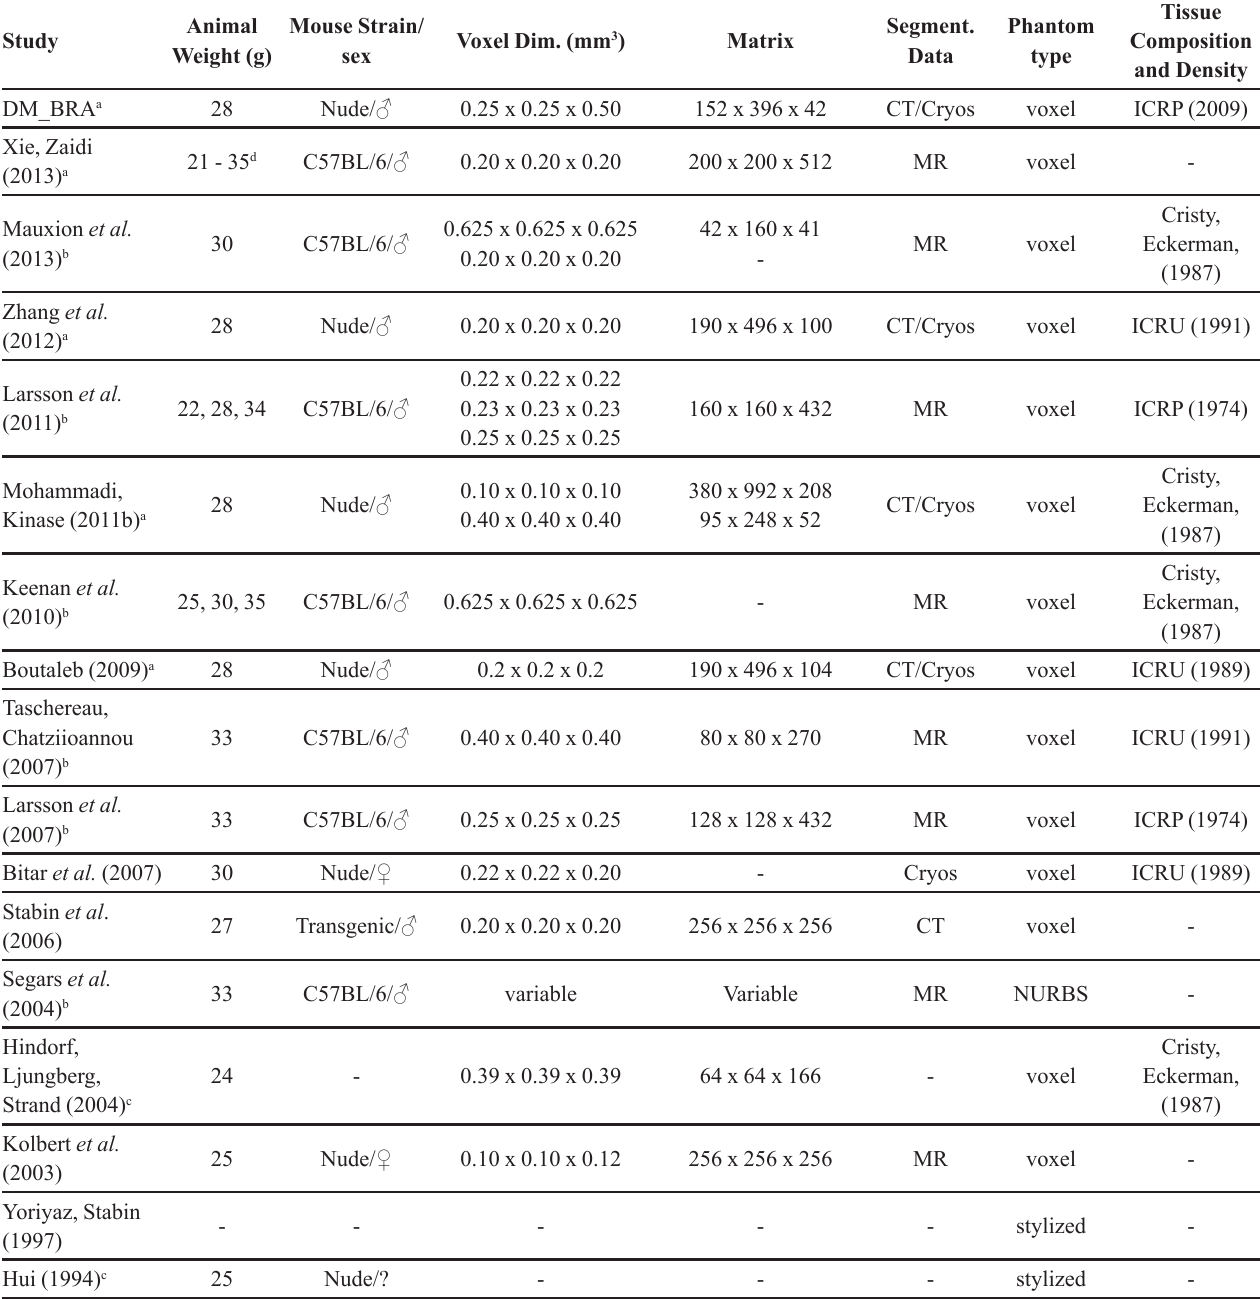
TABLE I - Summary of DM_BRA mouse voxel model characteristics and comparison with the main phantoms available in the